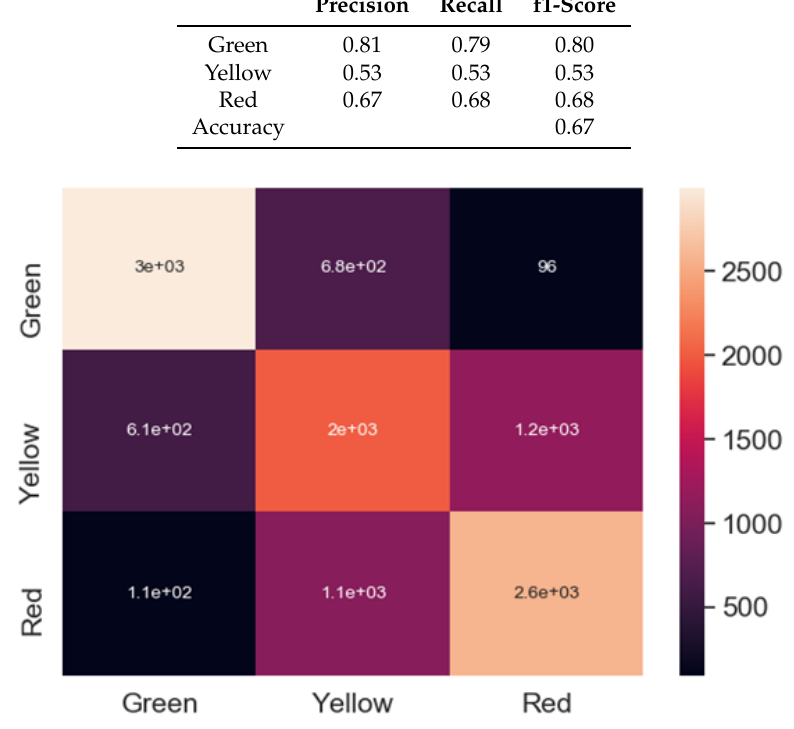
Figure 8. Confusion matrix for the Siamese model with no window